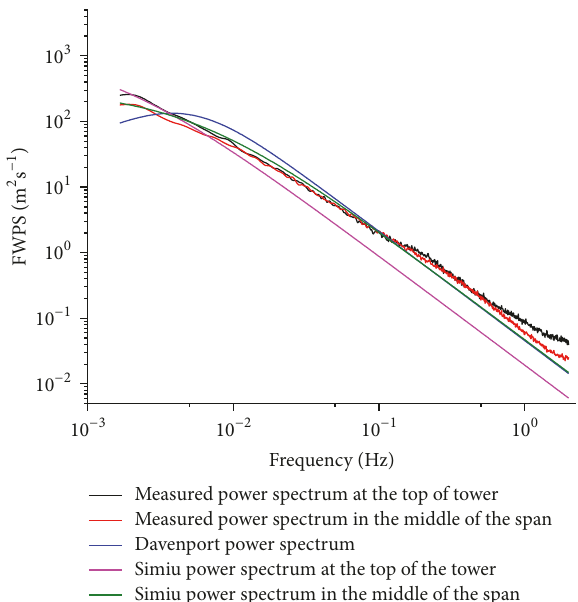
Figure 10: Measured FWPS and eFWPSs given in